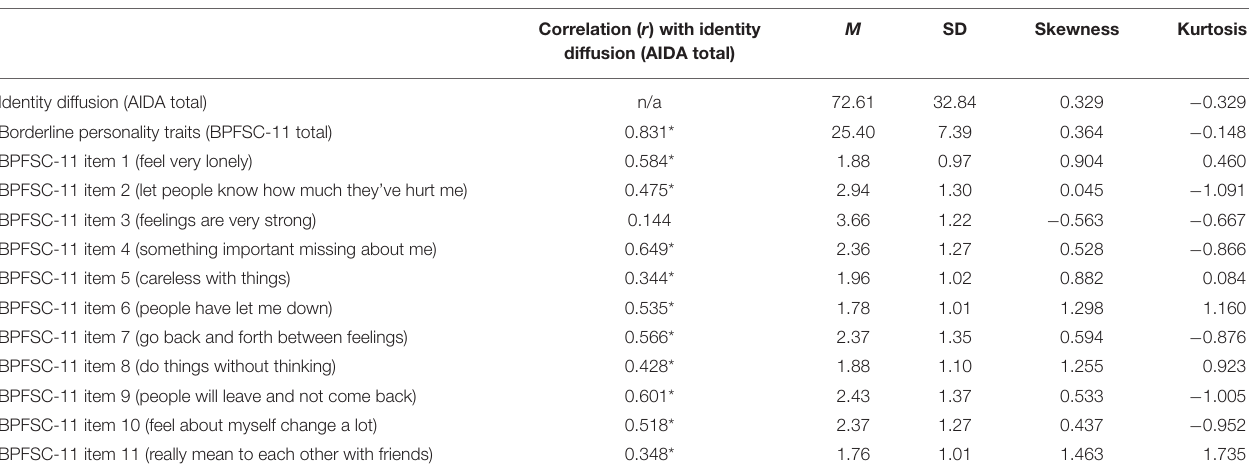
TABLE 1 | Descriptive statistics for measured